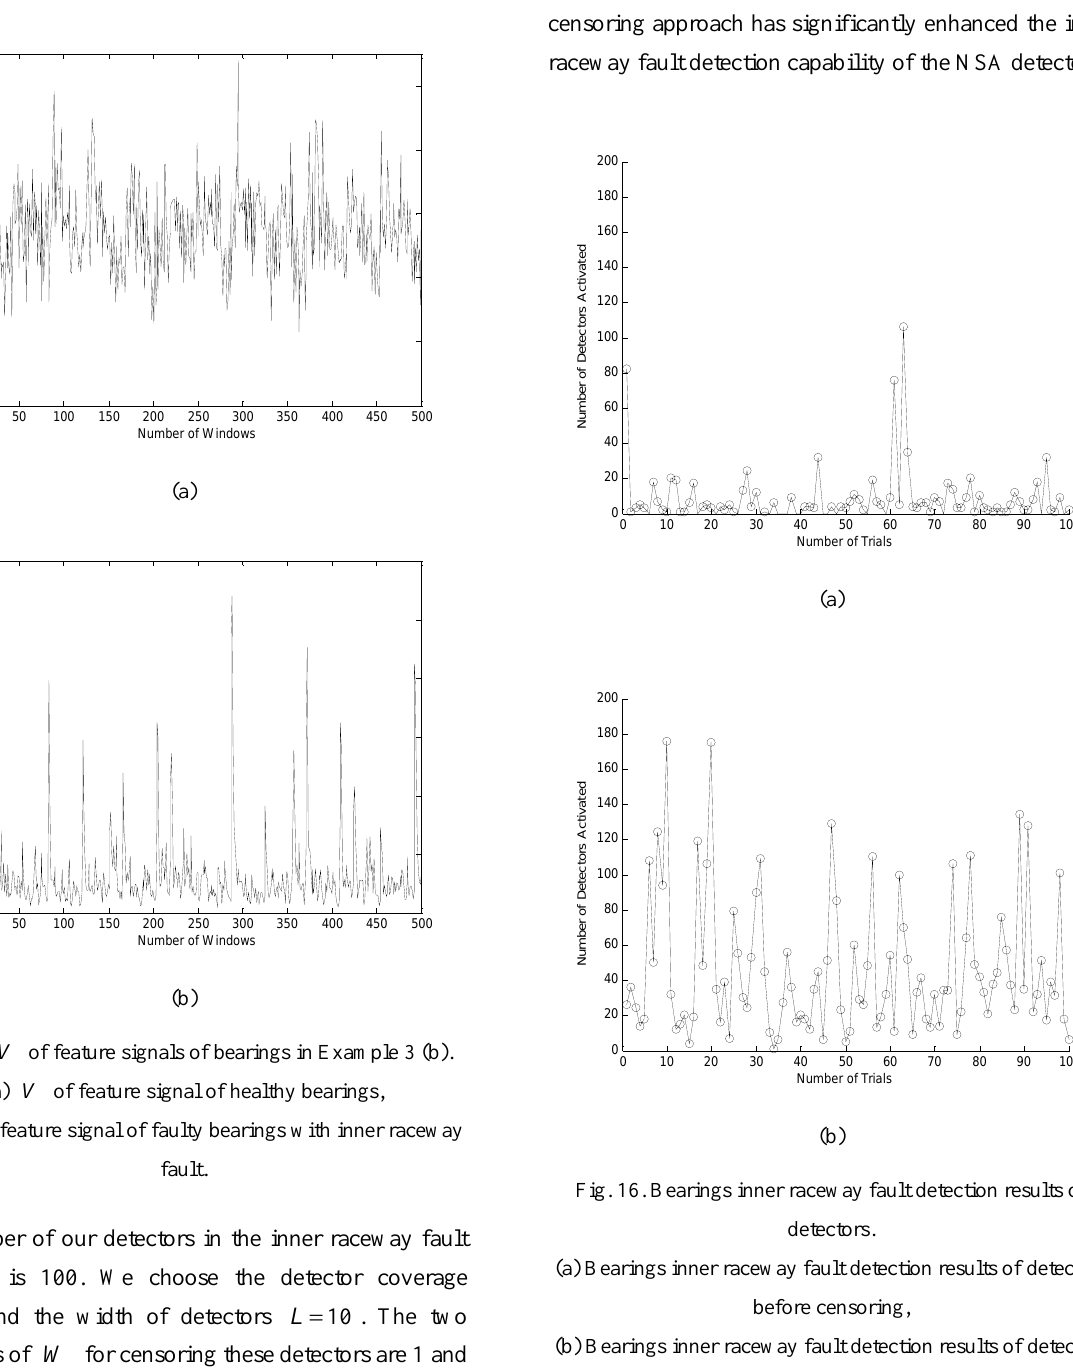
Fig. 16. Bearings inner raceway fault detection results of